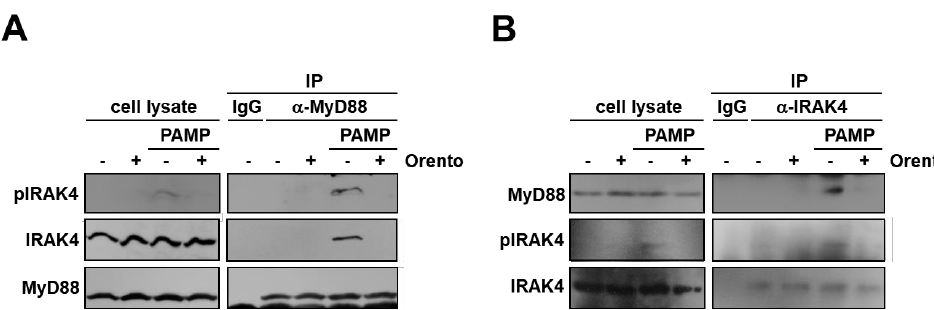
Figure 4. The effects of orento on binding between MyD88 and IRAK4 under PAMP stimulation in CAL27 cells. ( A ) Proteins in the cell lysates described in the legend of Figure 3 were immunoprecip- itated (IP) using anti-MyD88 antibody, with IgG being the control. Precipitates and cell lysates were analyzed by Western blotting using anti-phosphorylated IRAK4 (top), anti-IRAK4 (center), and anti-MyD88 (bottom) antibodies. ( B ) Proteins in the cell lysates were immunoprecipitated using anti-IRAK4 antibody, with IgG being the control. Precipitates were analyzed using Western blotting using anti-MyD88 (top), anti-phosphorylated IRAK4 (center), and anti-IRAK4 (bottom) antibodies.